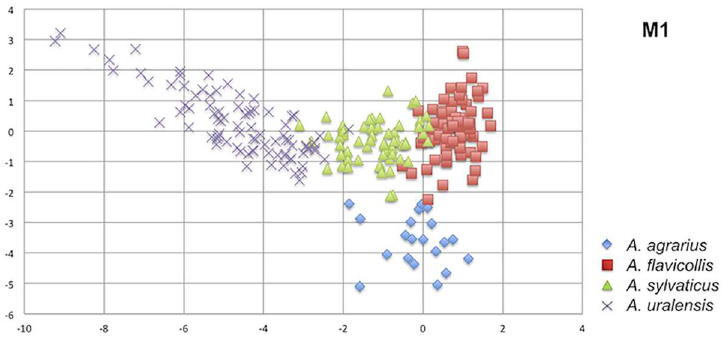
Fig 3. Plot of discrimination scores (R1/R2) of Recent Apodemus spp. based on metric variables of M1 (M1U –M17U). Note the distinct position of A . agrarius and the considerable overlapamong particular species of the subgenus Sylvaemus .